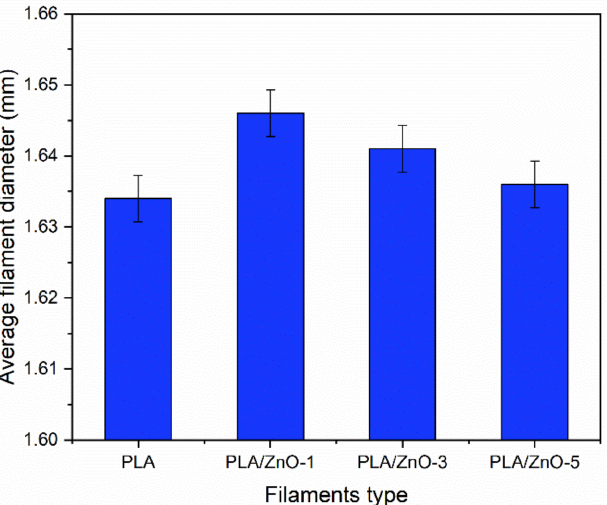
Figure 2. Average filament diameters from neat PLA and PLA composited with ZnO nanoflowers at varying contents.